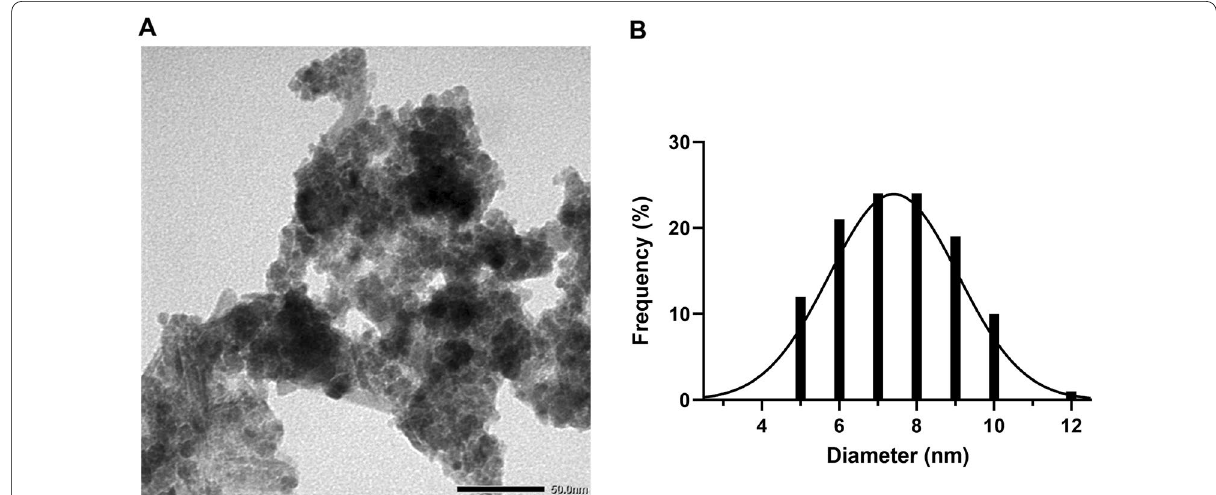
Fig. 2 Transmission electron microscopy (TEM) image and size distribution of oleic acid‑coated magnetic nanoparticles (Fe 3 O 4 @OA). ( A ) TEM image, scale bar: 50 nm. ( B ) Size distribution, n 100 =